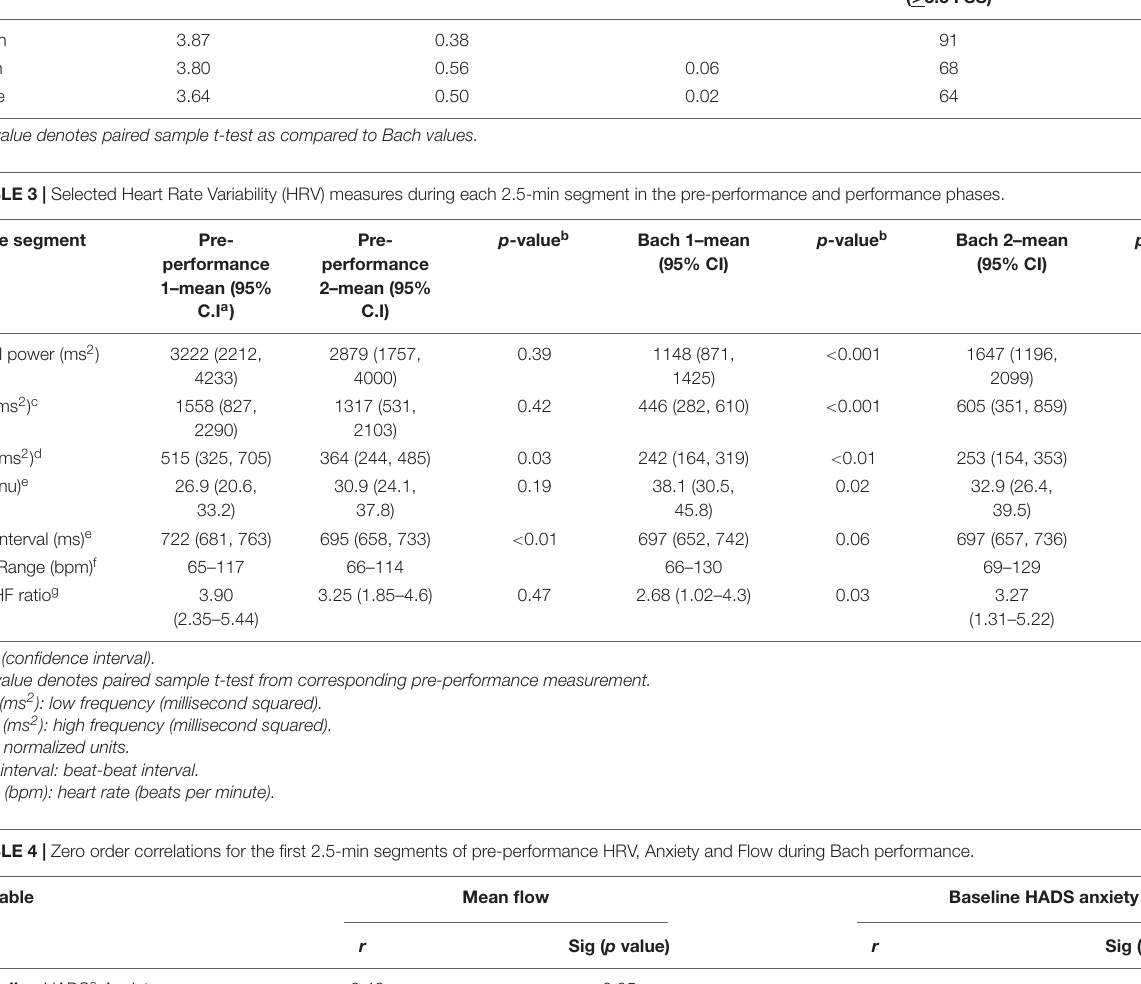
TABLE 2 | Mean flow and percentage of participants experiencing positive flow during performance of the three different music pieces. Piece Mean flow Standard deviation p -value a % of sample Bach